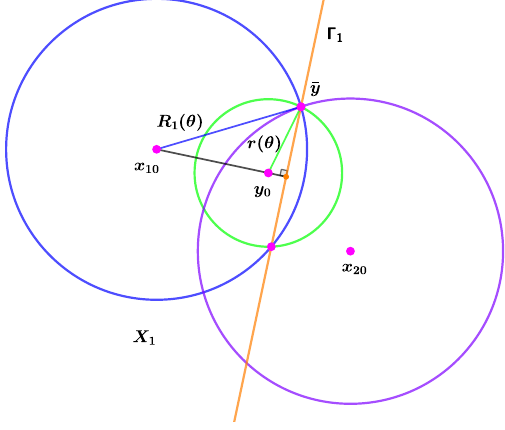
Figure 3. Half space X 1 bounded by Γ 1